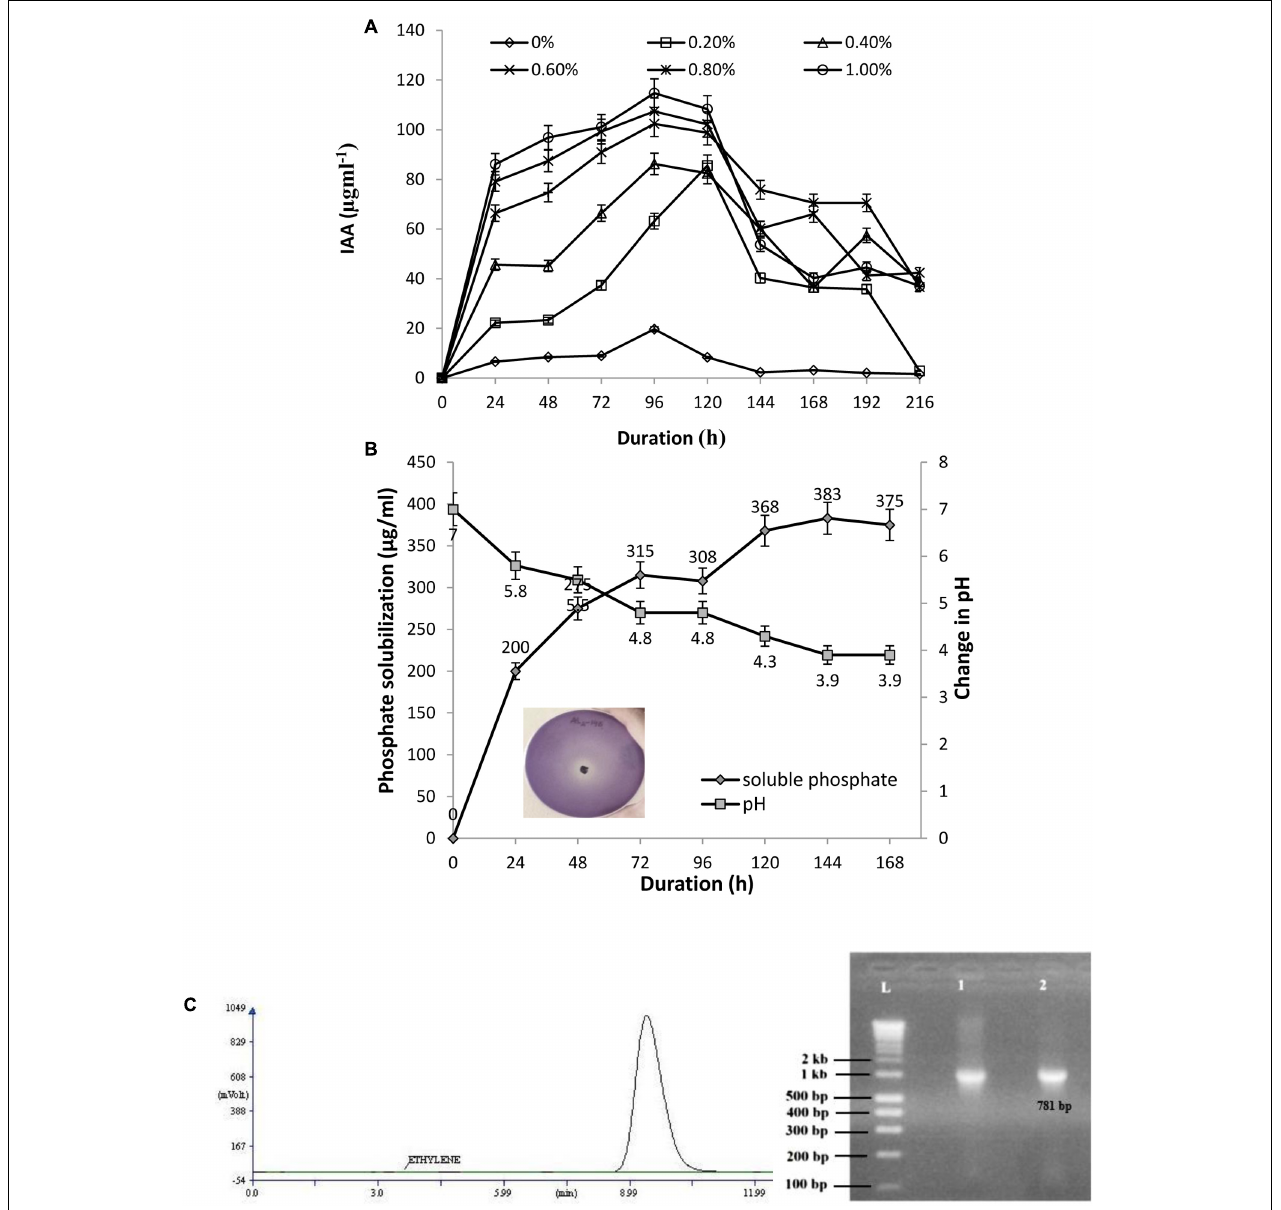
FIGURE 3 | (A) Quantitative estimation of IAA produced by AL2-14B at different L -tryptophan concentrations; (B) phosphate solubilization by AL2-14B after different time intervals. Soluble free phosphate concentration is given against primary y -axis, while variation of pH in the culture medium is given at secondary y -axis. Standard deviation showed as bars. Photograph represents the zone of clearance around colony of AL2-14B confirming its role in phosphate solubilization; (C) nitrogen fixation: acetylene reduction assay for nitrogenase activity, and nifH amplification (L, ladder; lane 1, Klebsiella pneumoniae S4C9 as positive control; lane 2,